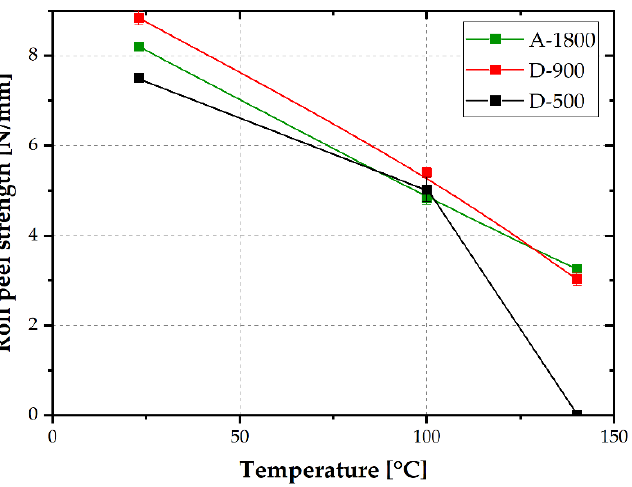
Figure 8. Roll peel strength at 23, 100 and 140 °C of laminates made from epoxy varnishes with EEW values of 500, 900 and 1800 g/mol.